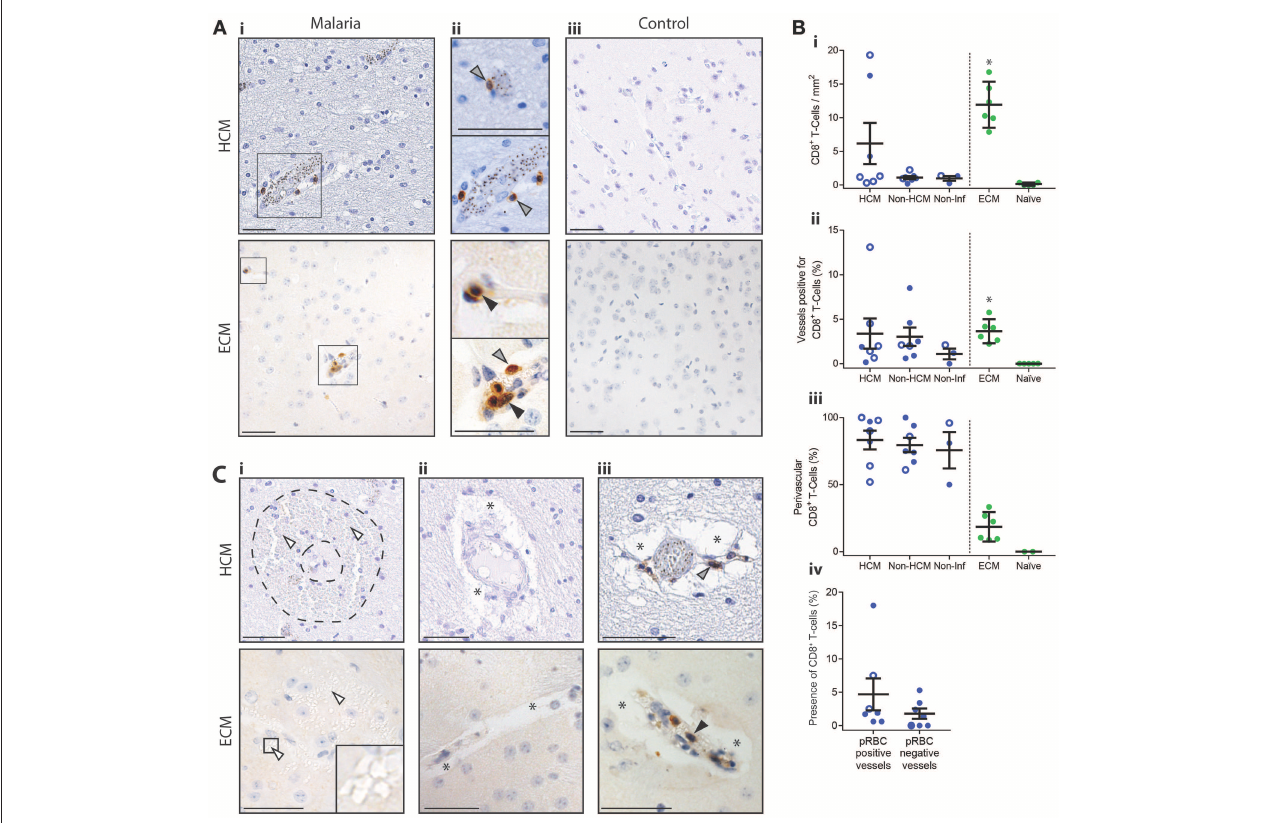
FIGURE 1 | Distribution of intracerebral CD8 + T cells in the cortex in HCM and ECM. The presence of intracerebral CD8 + T cells was assessed by immunohistochemistry in fatal HCM cases, in C57BL/6 mice that developed late-stage ECM after Pb ANKA infection, and in appropriate controls. (A) Representative images from HCM and ECM cases showing (Ai) low magnification and (Aii) high magnification identification of both luminal (black arrows) and perivascular (gray arrows) CD8 + T cells, in capillaries and large caliber vessels. (Aiii) Representative images showing lack of CD8 + T cells in brains of HCM controls (CM9) and naïve mice. (B) Several parameters of CD8 + T cell accumulation were quantified: (Bi) absolute numbers of CD8 + T cells per mm 2 , (Bii) percentage of total vessels with CD8 + T cells (either luminal or perivascular), (Biii) percentage of CD8 + T cells that were perivascular, (Biv) percentage of vessels in HCM cases with CD8 + T cells separated into vessels with and without parasitized red blood cells (pRBCs). HCM = CM1 (filled circles) and CM2 (open circles) cases, Non-HCM = CM3 (filled circles) and CM7 (open circles), Non-Inf = CM9 (filled circles) and CM11 (open circles). (C) Representative images from HCM cases and ECM samples showing: (Ci) intracerebral hemorrhage (white arrows indicate red blood cells, note classical ring hemorrhage in HCM, demarcated by dotted outline), areas of vasogenic edema (asterisks) without (Cii) and with CD8 + T cells (Ciii). Scale bars = 50 µ m. * p < 0.05. Human cases were compared by one-way ANOVA with Holm-Sidak’s multiple comparisons test, ECM was compared to naïve by Student’s t -test, and presence of CD8 + T cells in pRBC positive and negative vessels was compared by Student’s t -test.